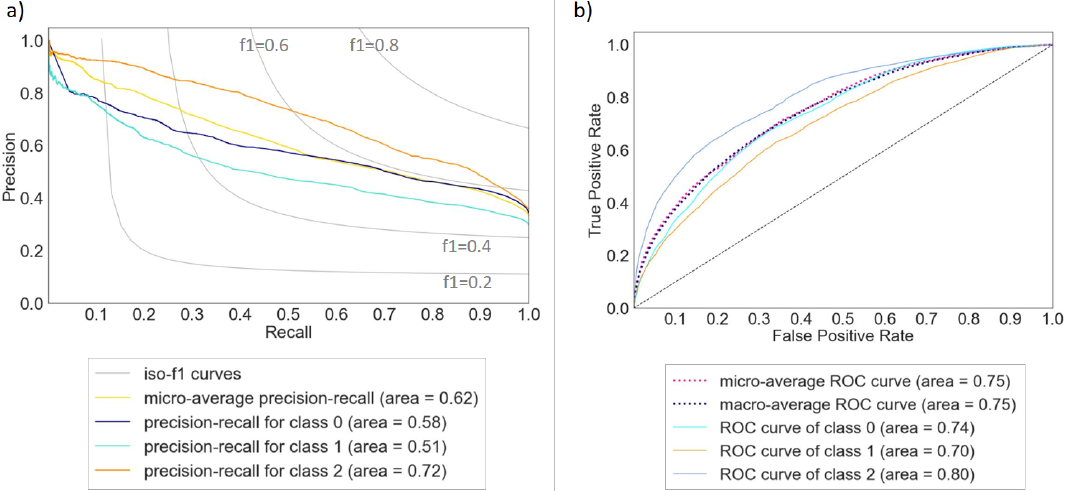
Figure 5. Random forests simulation results: ( a ) precision–recall curve; ( b ) ROC